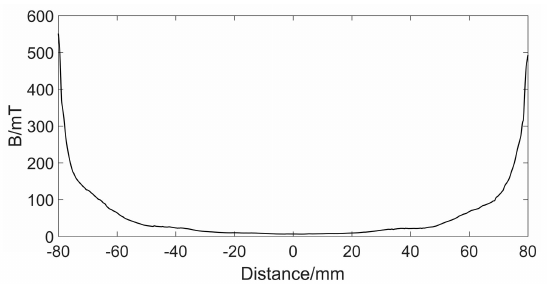
Figure 6. Magnetic flux density change from magnetic poles to the intermediate position of the